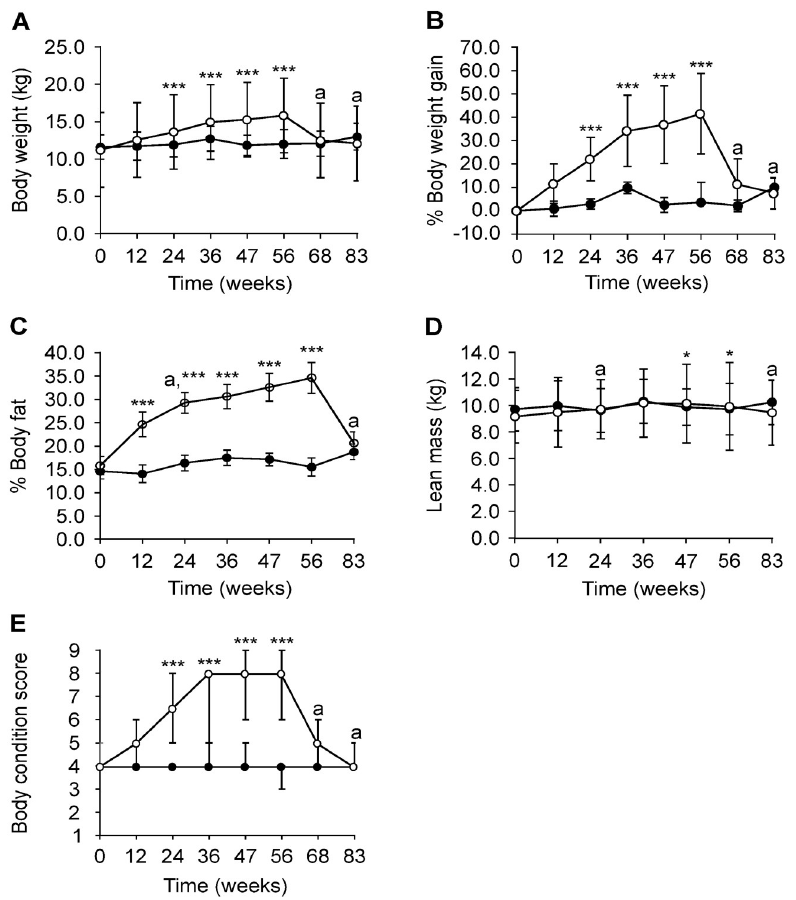
Fig 4. Body characteristics of beagles in the control (closed circles; n = 8) and weight-change (open circles; n = 8) group during the weight-gain phase (week 0–47), weight-stable phase (week 47–56) and weight-loss phase (week 56–83). Body weight (kg) (A), % body weight gain (B), % body fat (C) and body condition score (E) increased significantly from week 12 or week 24 until week 56 in the weight-change group compared to the control group. Lean mass (kg) was significantly increased at week 47 and 56 in the weight-change group. Data is shown as mean ± SD. a Data from one dog missing in the control group. ��� P = 0–0.001, �� P = 0.001–0.01 and � P = 0.01–0.05 for the group x time interaction, after multiple correction. despite a slight decrease in energy intake (843 ± 127 kJ/kg 0.75 ideal body weight). Lean mass (kg) also significantly increased at these two time points while the BCS remained stable (week 47: 9.9 ± 1.8 vs. 10.2 ± 2.4 kg, P = 0.018; week 56: 9.8 ± 1.9 vs. 10.0 ± 2.5 kg, P = 0.040) (Fig 4D). During weight-loss (week 68–83), energy intake of the weight-change group was 548 ± 146 kJ/kg 0.75 ideal body weight. By week 83, the weight-change group lost 23.4 ± 6.8% of body weight and the BCS was 4/9 for all dogs. The body fat % of this group also decreased from week 56 to 83 (-14.0 ± 4.2%). In contrast, the BCS of the control group remained within the ideal range (BCS 4–5) throughout the study, except for one dog at week 56 (with BCS 3). Energy intake throughout the study was 659 ± 156 kJ/kg 0.75 based on ideal body weight.